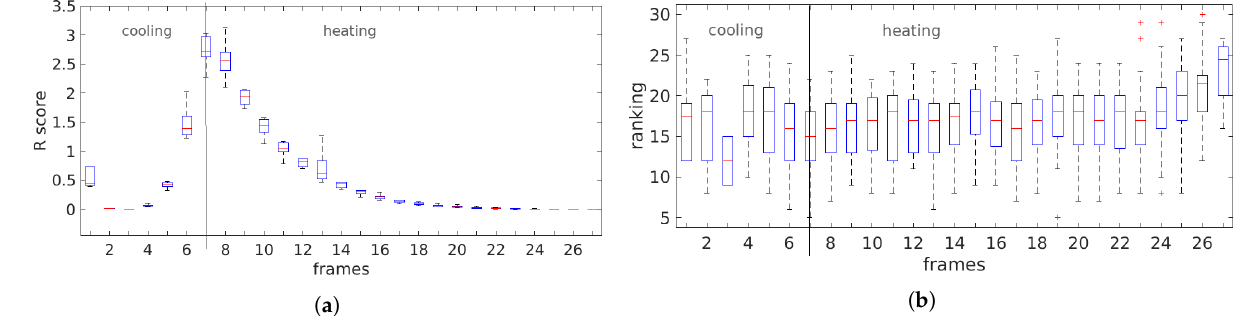
Figure 13. Box and whisker plots of ( a ) R score and ( b ) ranking for all 27 frames of